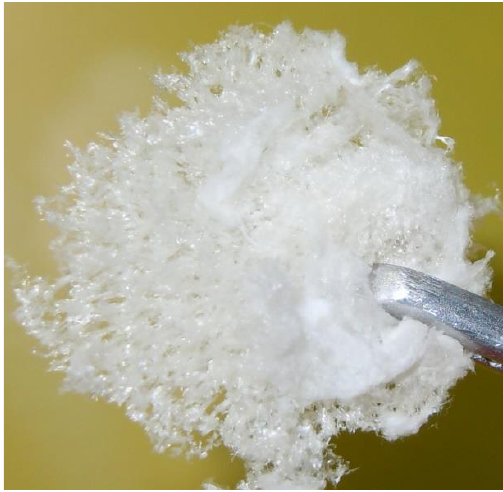
Figure 5. Photo of the obtaining MFC after freeze drying.